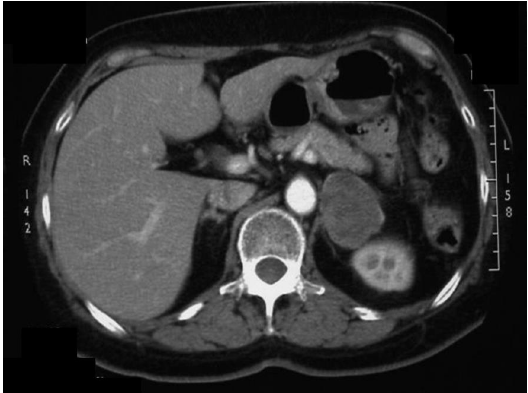
Figure 1. Computed tomography and ultrasound examination show a 4-cm left adrenal tumor.